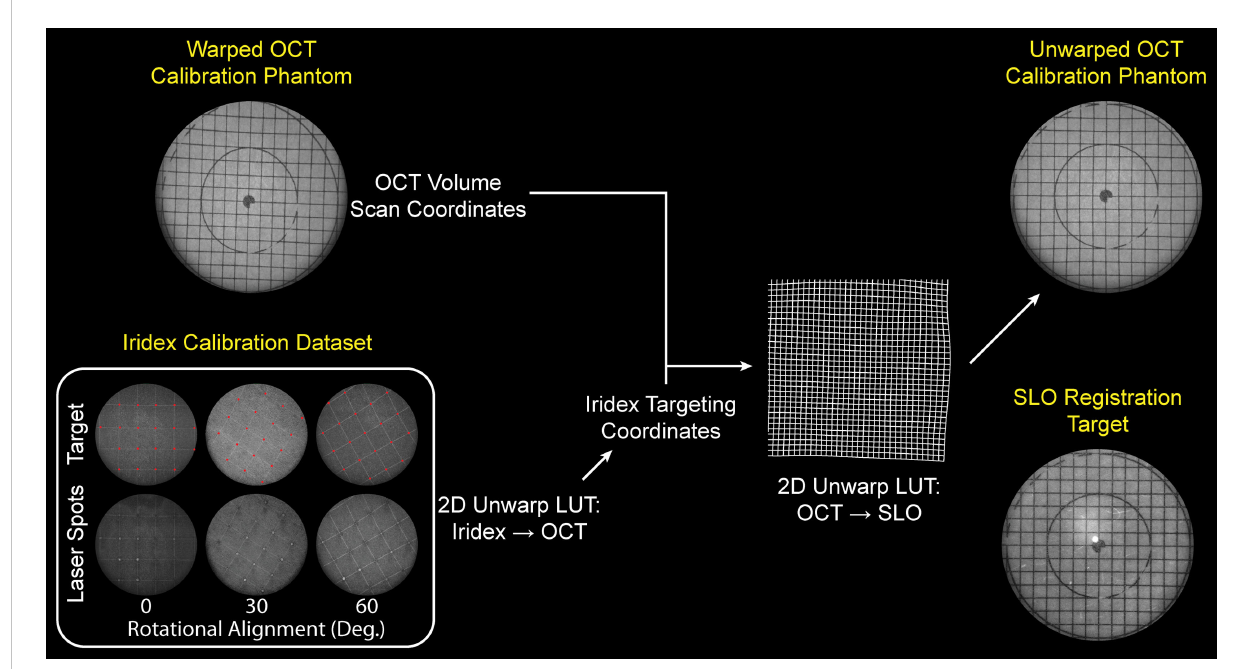
FIGURE 4 Laser lesion aiming calibration and OCT-SLO image co-registration fl owchart. Inset shows target and actual lesion locations on grid calibration target used to calibrate laser lesion aiming locations to OCT FOV. Grid calibration target is imaged using both OCT and SLO and a 2-dimensional unwarp mask is computed to co-register OCT volumes to SLO images in